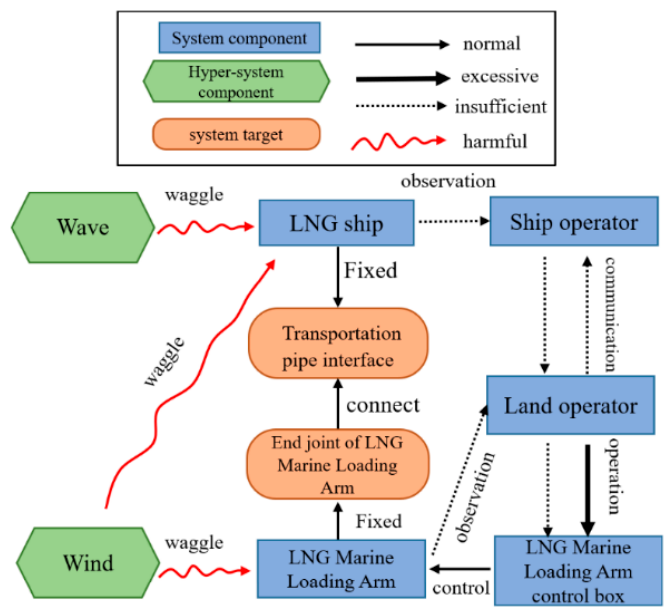
Figure 3. Functional model.